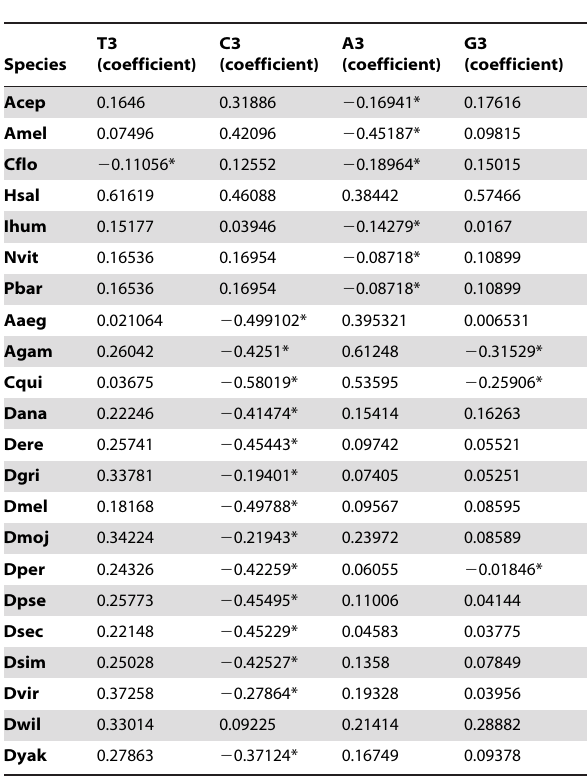
Table 2. Logistic regression coefficients of effective number of codons of genes within each genome as a function of base compositions at the 3rd position of